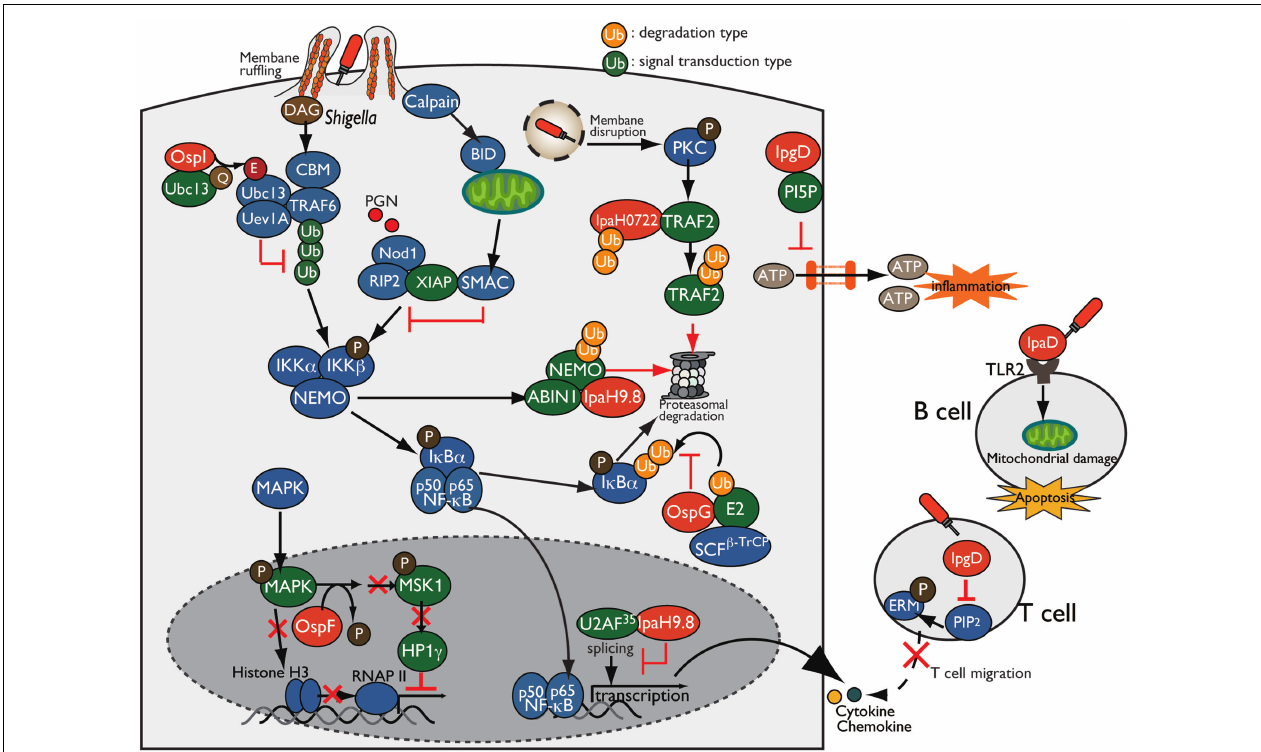
further targets U2AF35, preventing its participation in the splicing reaction via an unidentified bacterial factor, Shigella induces calpain-dependent BID activation, which, in turn, releases mitochondrial SMAC to antagonize XIAP-mediated inflammation. IpgD-mediated hydrolysis of PIP2 inactivates ERMs of T cells, which crosslink actin filaments with the plasma membrane, thereby preventing T cell migration. Shigella induces B cell death in both invaded and non-invaded cells. In non-invaded cells, the T3SS needle-tip protein IpaD interacts with TLR2 on B cells and triggers mitochondrial damage, which eventually induces